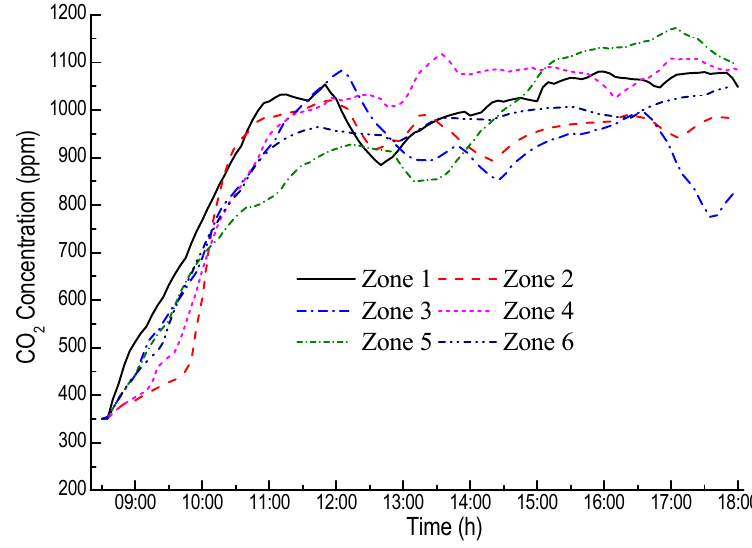
Figure 7. The CO 2 concentration of six zones under Scenario 2.